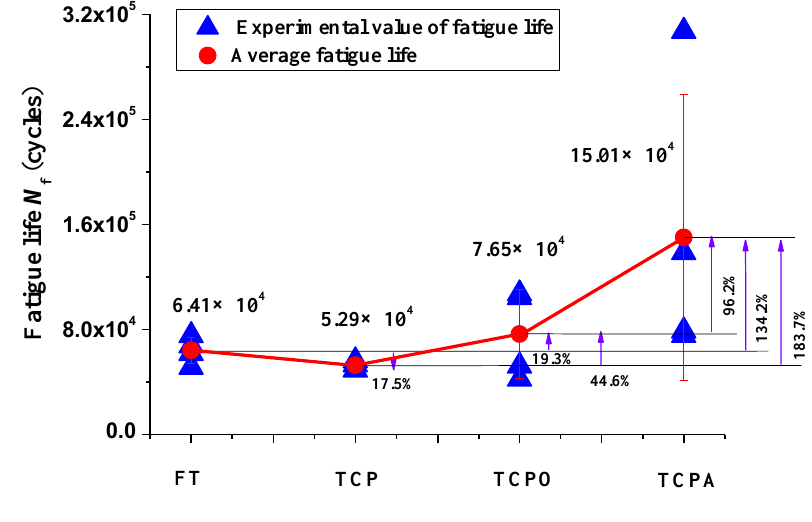
Figure 8. Average fatigue lives.